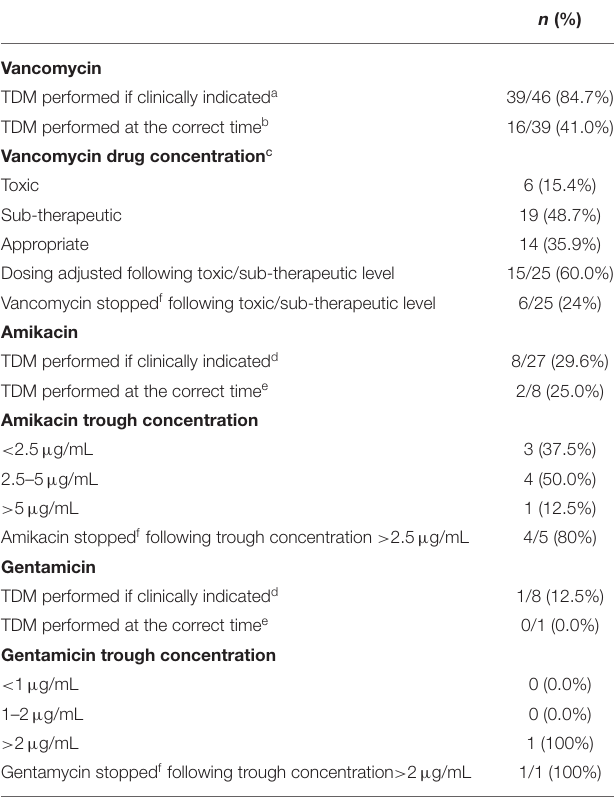
TABLE 6 | Therapeutic drug monitoring (TDM) of selected antimicrobials for neonatal BSI episodes.